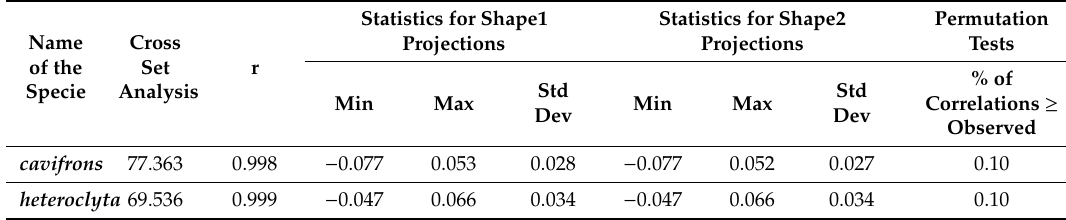
Figure 5. Shape analysis of Anomiopsoides male head. ( a ) Scatterplot of the RWs 1 and 2, which accounted together for about 73% of the overall shape variation of the head. ( b ) Deformation grid of the A. heteroclyta group from the tpsRegr analysis. ( c ) Deformation grid of the A. cavifrons group from the tpsRegr analysis. Table 2. Results of the PLS analysis and subsequent Permutation Tests (nReps = 999) for D1 in both Anomiopsoides species (shape1 = original, shape2 =